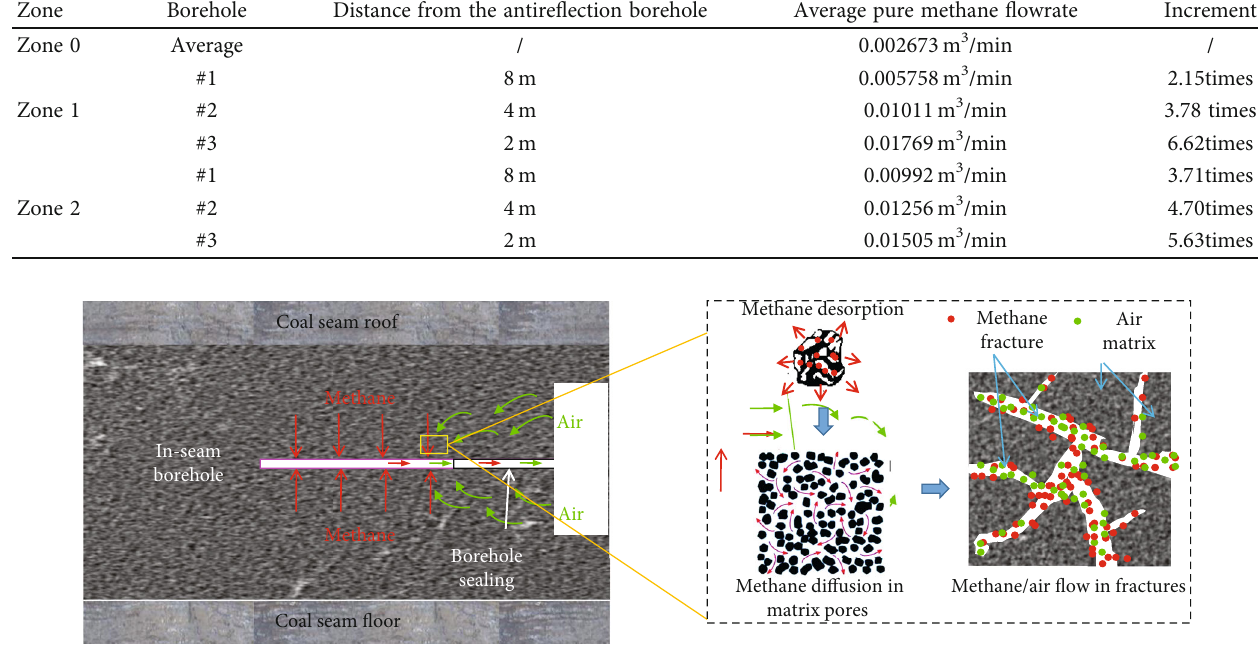
Figure 6: Illustration of gas fl ow surrounding the borehole with air